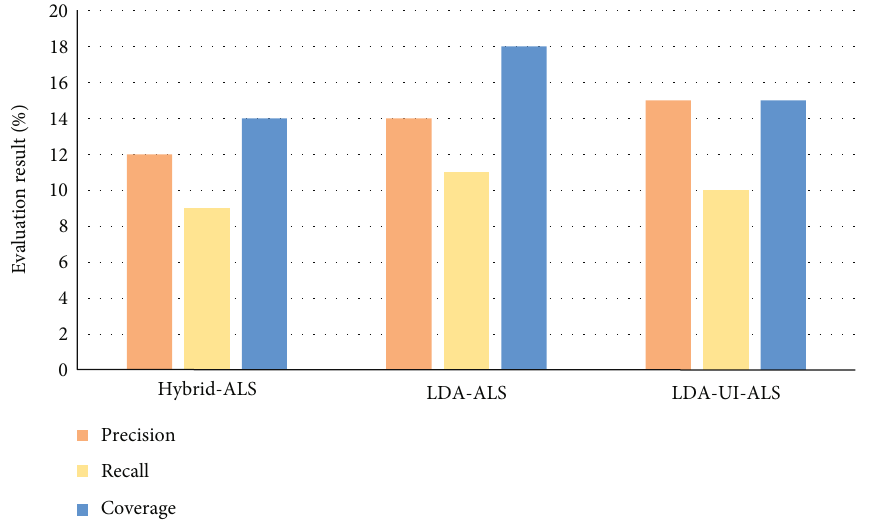
Figure 7: Evaluation and comparison histogram of three algorithms under di ff erent reference